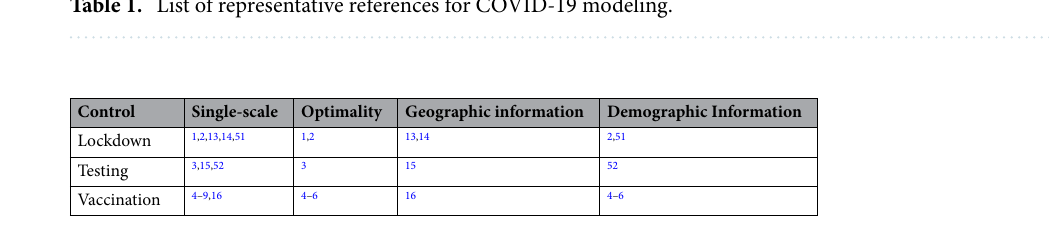
Table 2. List of representative references for COVID-19